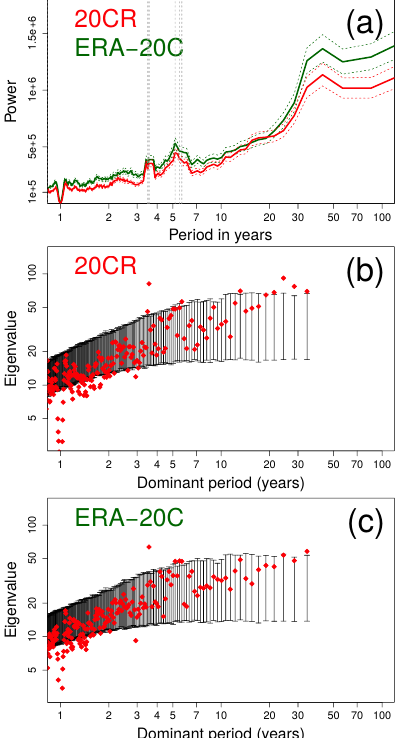
Figure 4. (a) Total spectrum of 20CR (red line) and ERA-20C (green line) with their min.–max. confidence intervals. The unit of the spectral density is arbitrary. (b) Significance of the 20CR pe- riodicities against red noise null hypothesis. Shown are the data eigenvalues (red squares) and the 2.5th and 97.5th percentiles of the eigenvalue distribution of the red noise surrogates (vertical bars). (c) Same as (b) , but for the ERA-20C data